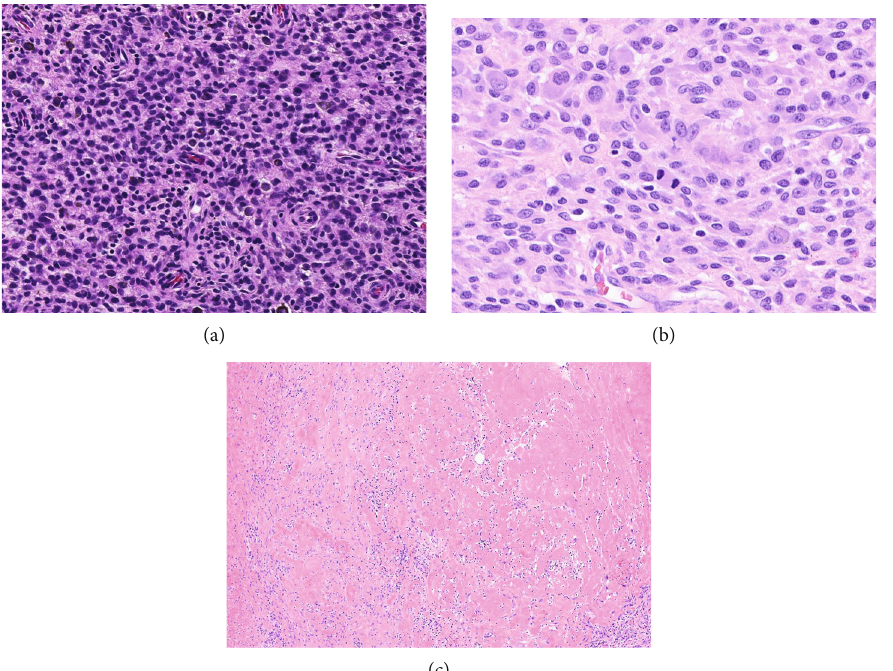
Figure 11: Histology images in the knee post-pexidartinib treatment. Hypercellular region of the popliteal tumor after pexidartinib treatment is indistinguishable from that seen in the original biopsy (a). This photomicrograph displays areas of highly mitotic proliferative tumor (19 mitoses per 10 high power fi elds) that were widely seen in the viable tumor (b). Approximately, 30% of the mass was composed of these areas of fi brotic hypocellular tissue with low proliferative rates